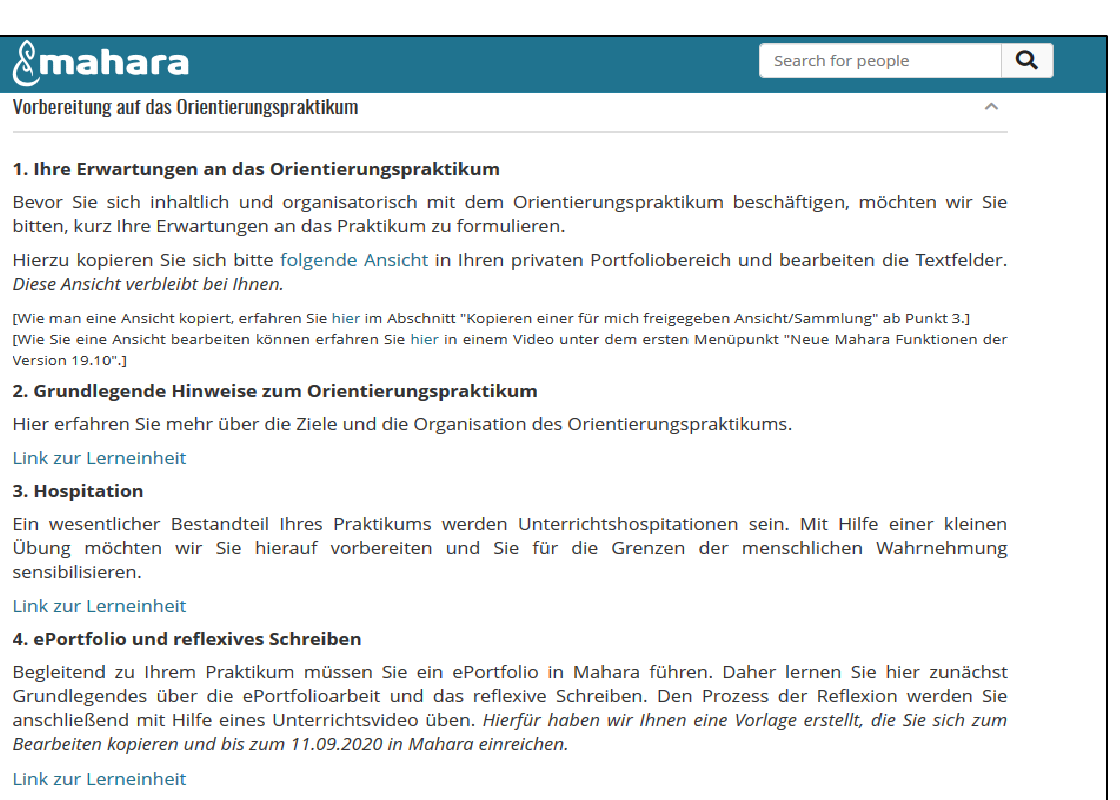
Figure 1: Learning units provided at the group